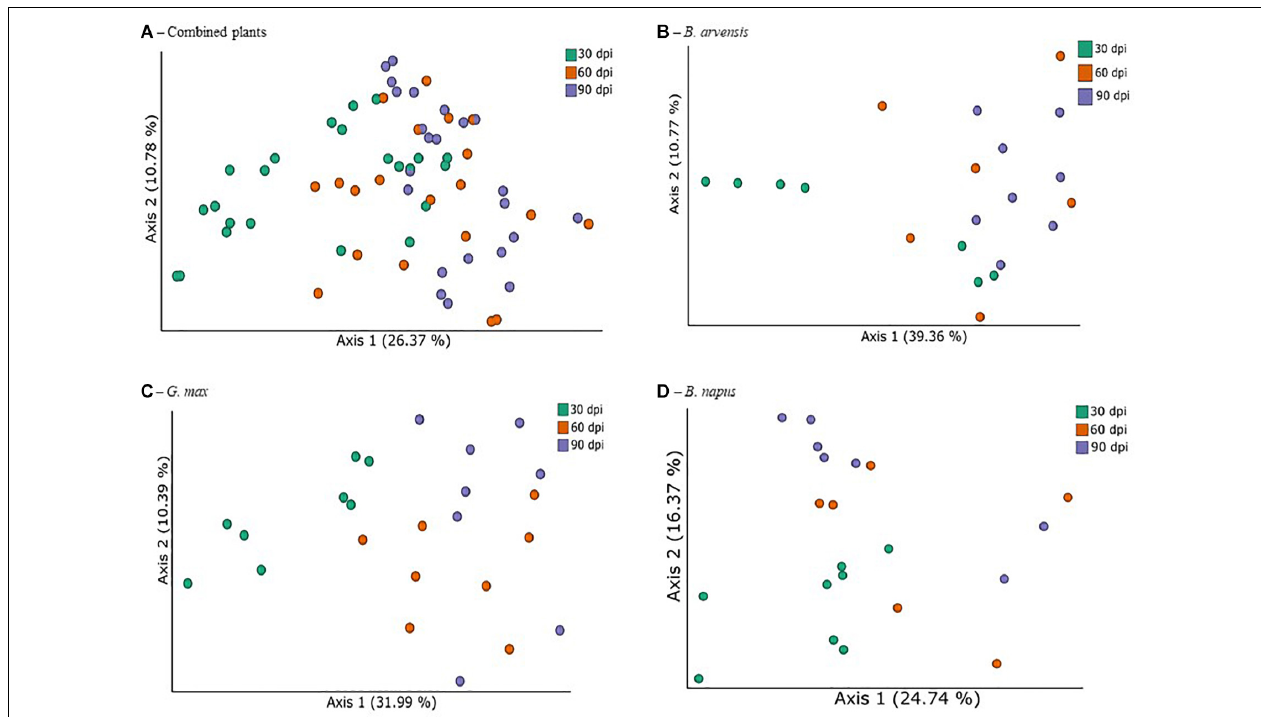
FIGURE 5 | Temporal variations of beta-diversity metrics in the bacterial microbiome of three oil-producing crops. (A) PCoA plot representative of temporal beta-diversity variations using weighted UniFrac metric for all plants and treatments combined ( F = 5.51, p = 0.001). Each point represents a sample, (B) PCoA plot representative of temporal beta-diversity variations using weighted UniFrac metric for all B. arvensis plants and treatments combined ( F = 2.67, p = 0.005). Each point represents a sample, (C) PCoA plot representative of temporal beta-diversity variations using weighted UniFrac metric for all G. max plants and treatments combined ( F = 4.01, p = 0.001). Each point represents a sample, (D) PCoA plot representative of temporal beta-diversity variations using weighted UniFrac metric for all B. napus plants and treatments combined ( F = 2.19, p = 0.002). Each point represents a